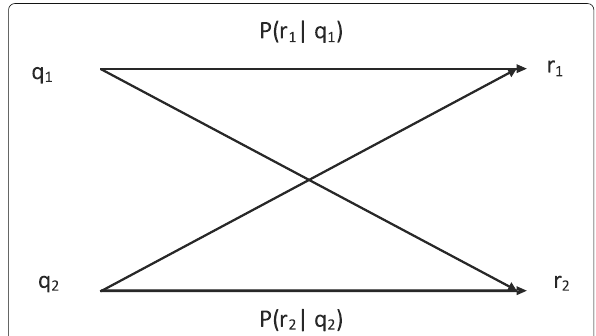
Fig. 9 Approximation of proposed watermarking technique as a binary channel. q 1 , q 2 and r 1 , r 2 are the input and output probabilities of binary watermark image, respectively